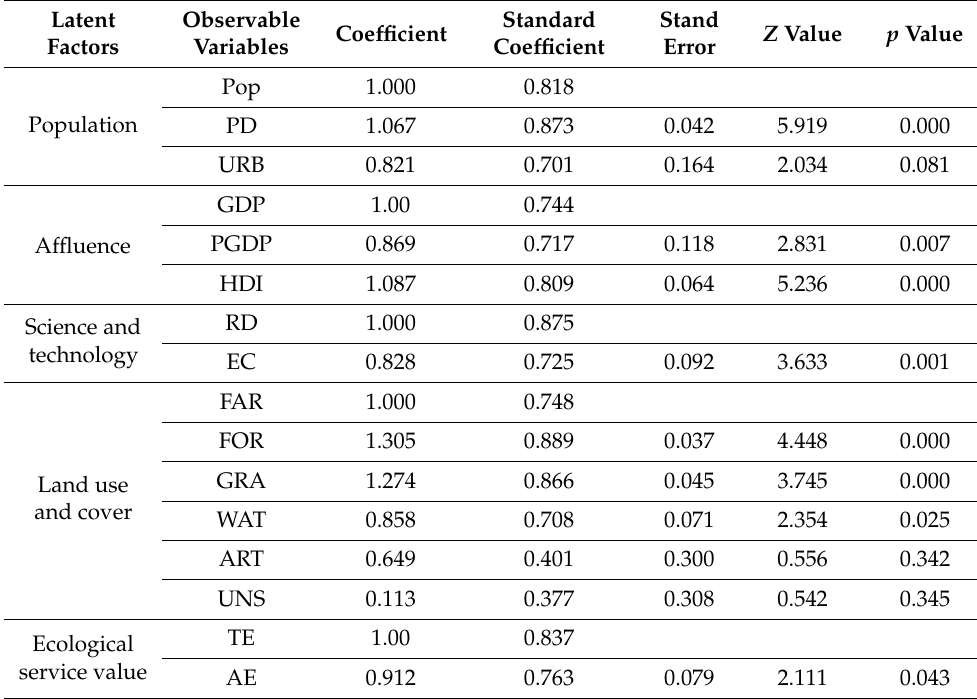
Table A3. Regression coefficients between latent and observable